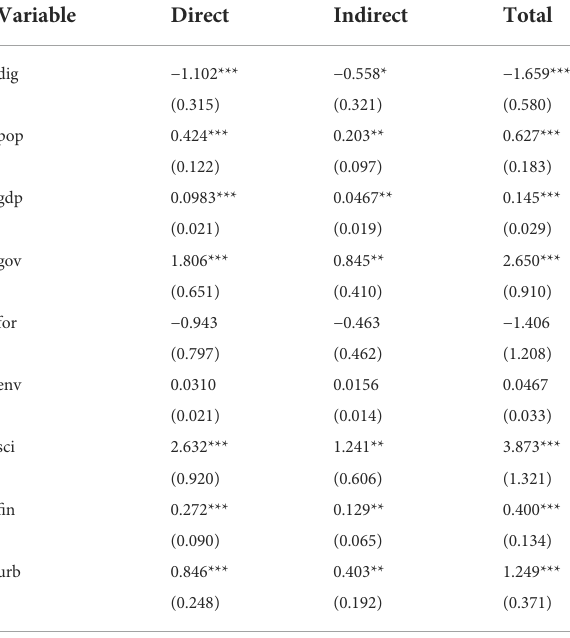
TABLE 6 Direct, indirect, and total effects of digital economy development on urban carbon emissions. Variable Direct